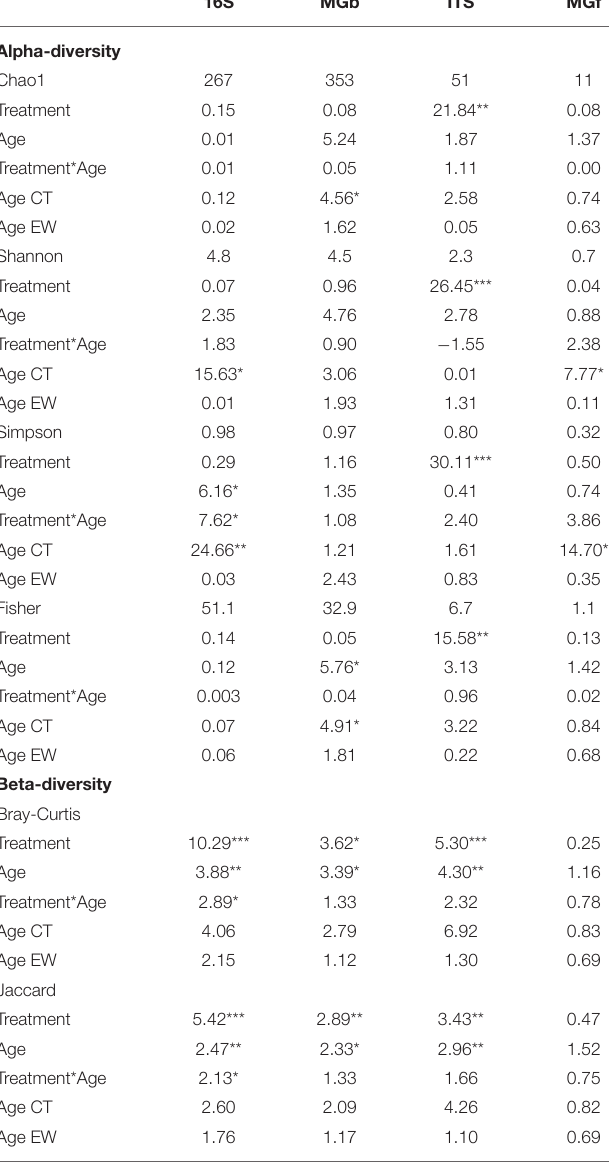
TABLE 2 | Linear model (LM) analyses of alpha-diversity indices and permutational multivariate analysis of variance of beta-diversity indices from metatatoxonomic (16S and ITS) and metagenomic (MG) strategies (b, bacteria; f,